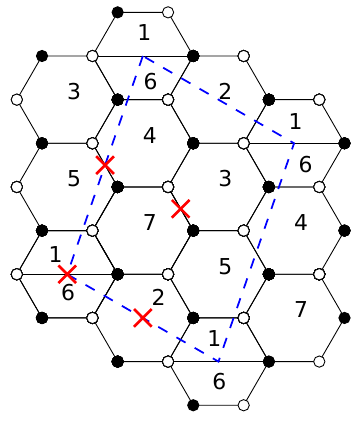
Figure 9 . PdP 4 b dimer with orientifold